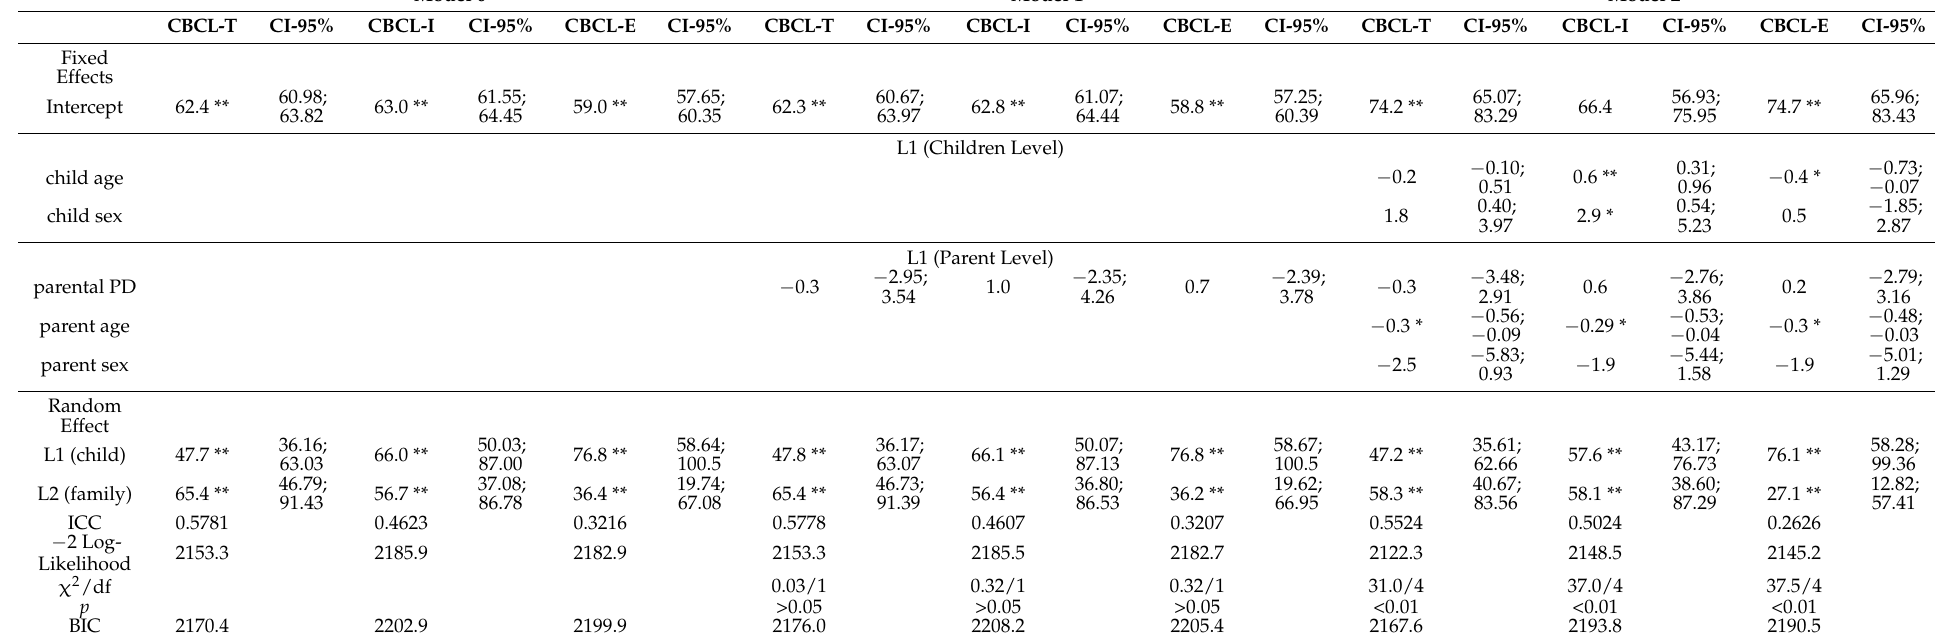
Table 5. Parental PD (ICD-10) as a predictor for CBCL (children’s psychiatric symptoms). Model